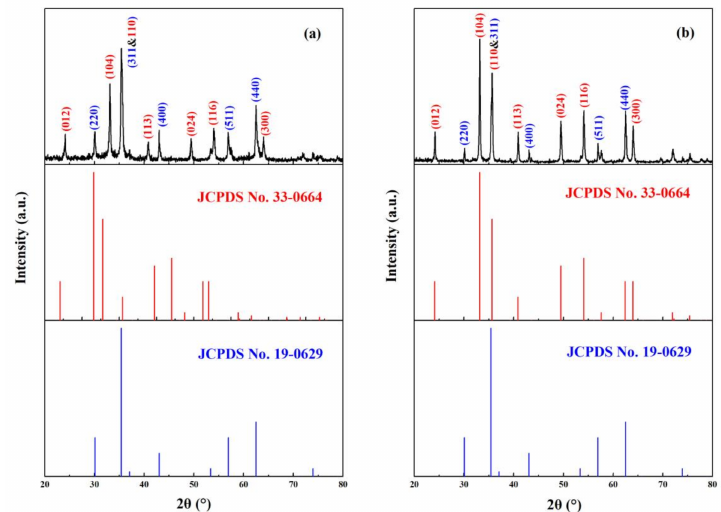
Figure 2. Comparisons of the XRD patterns of Fe 2 O 3 /Fe 3 O 4 heterogeneous nanoparticles calcined at 400 ( a ) and 500 ◦ C ( b ) for 2 h with the heating rate of 3 ◦ C/min and the molar ratio of ferric nitrate and urea of 1:4 with the standard PDF cards (Fe 2 O 3 : JCPDS No. 33-0664; Fe 3 O 4 : JCPDS No. 19-0629). Table 1. D-spacings of Samples A and B and those of Fe 3 O 4 , γ -Fe 2 O 3 , and α -Fe 2 O 3 from the